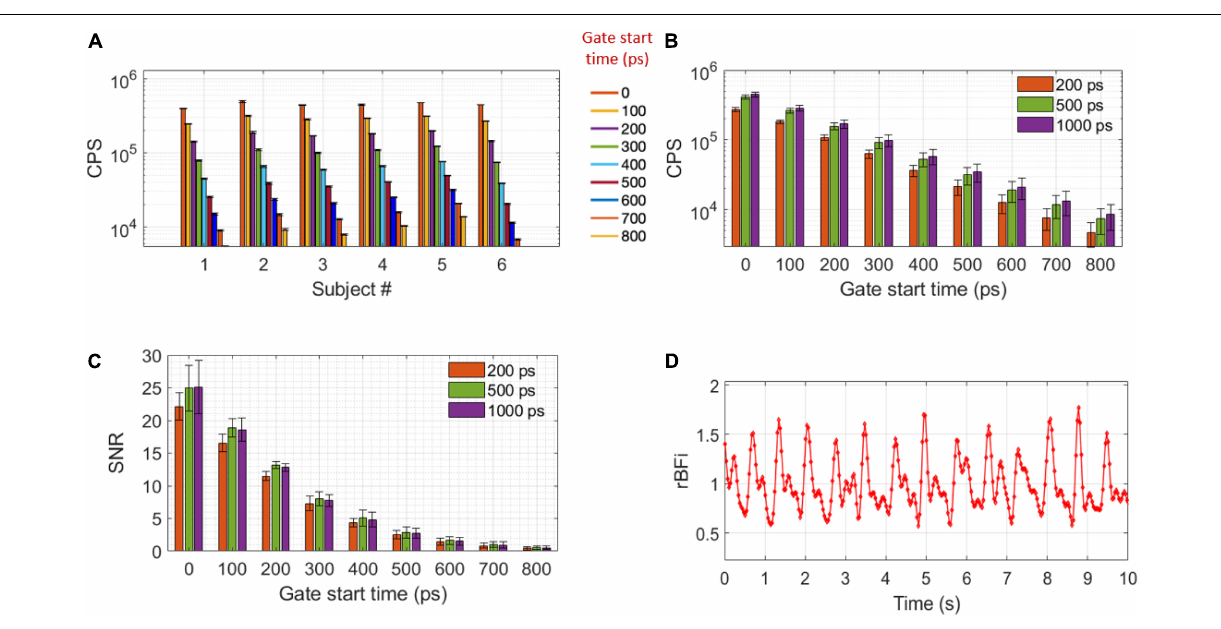
FIGURE 5 | CPS and SNR. (A) CPS of all the subjects at gate start times between 0 and 800 ps for a 1,000 ps gate width. Error bars represents temporal STD of the pressure modulation task baseline CPS (between 10 and 50 s). (B) CPS and (C) SNR at 200, 500, and 1,000 ps gate widths as a function of gate start time, error bars represent STD of all the subjects. (D) An example of BF i acquired at 30 Hz at late gate in subject # 3 (g 2 SNR = 5.8). A Butterworth bandpass filter of 0.1–5 Hz was applied to the